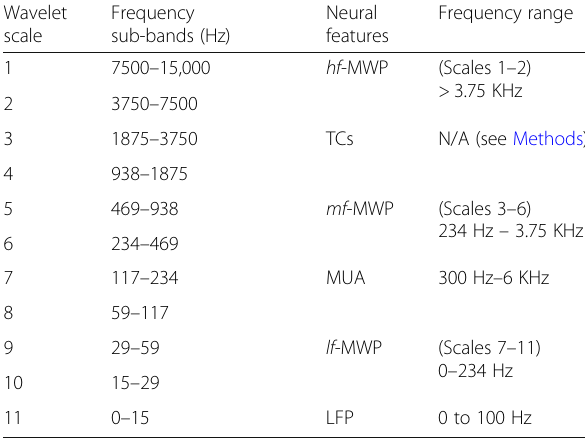
Table 1 Wavelet scales and frequency bands for neural features Wavelet Frequency scale sub-bands (Hz)